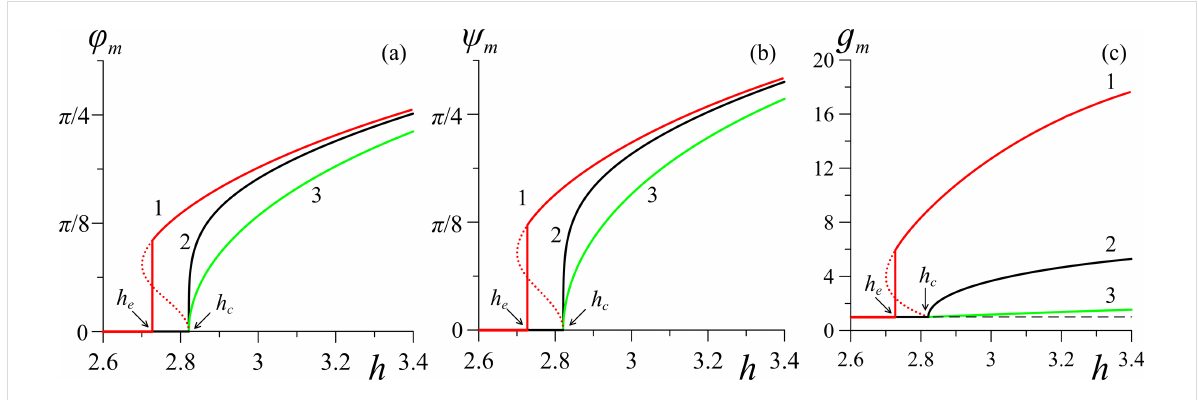
Figure 3: Dependencies of (a) the angle φ m , (b) the angle ψ m , and (c) the reduced CNT volume fraction g m in the center of the layer on the applied magnetic field h for γ = 0.2 and σ = 5: curve 1 – κ = 0.01; curve 2 – κ = κ * = 0.056; curve 3 – κ = 0.5. Here h c = 2.824, h e = 2.727.